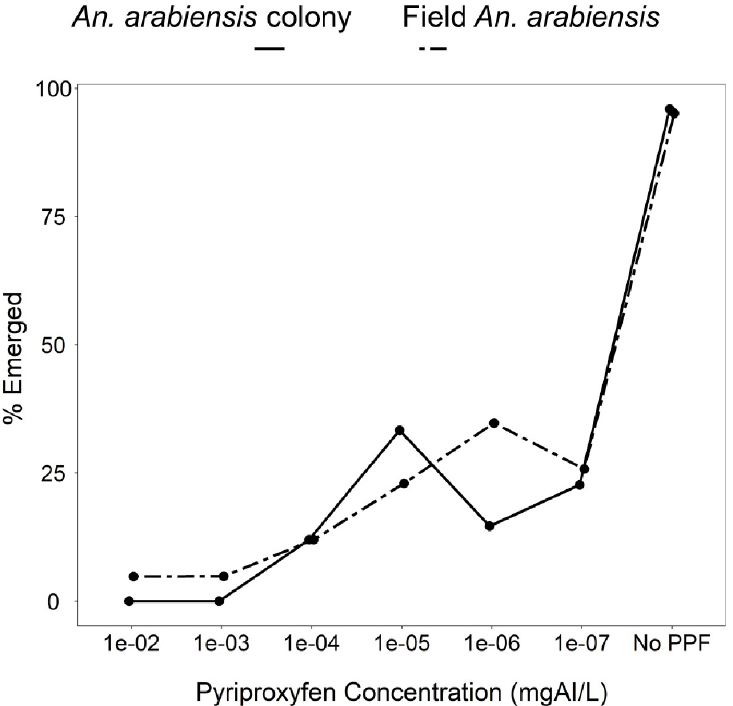
Fig 1. Percentage of mosquitoes emerging as adults from larval-rearing basins treated with different concentrations of pyriproxyfen (PPF): Anopheles arabiensis , from Kining’ina colony population; and field Anopheles arabiensis , from Namwawala